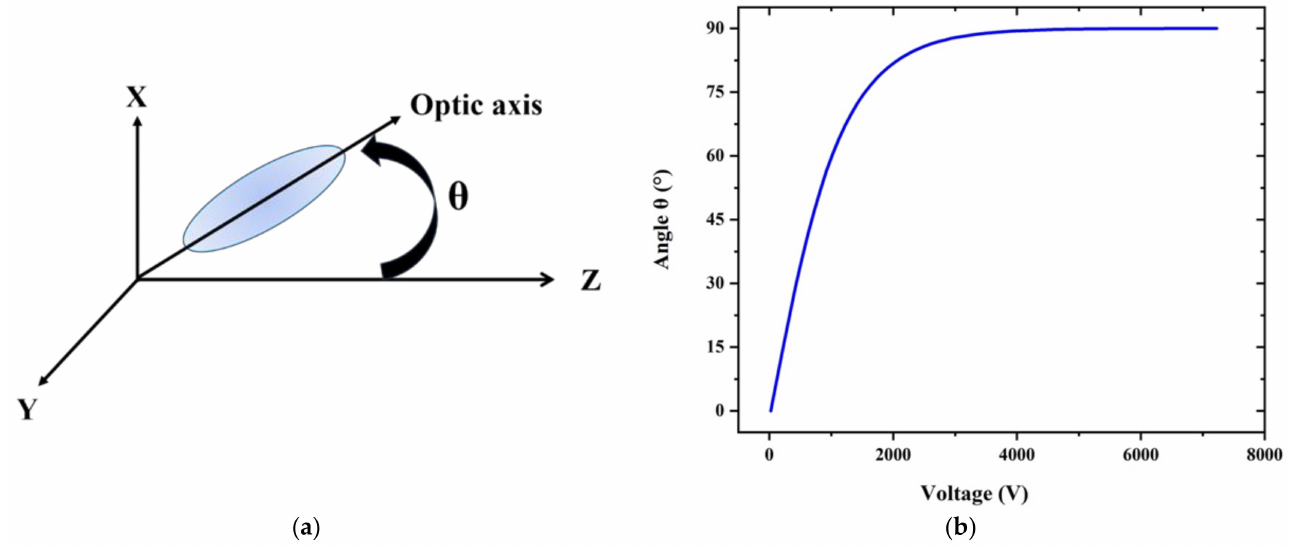
Figure 2. ( a ) The arrangement of liquid crystal molecules under an external electric field. ( b ) The relationship between the rotation angle of LC and ambient